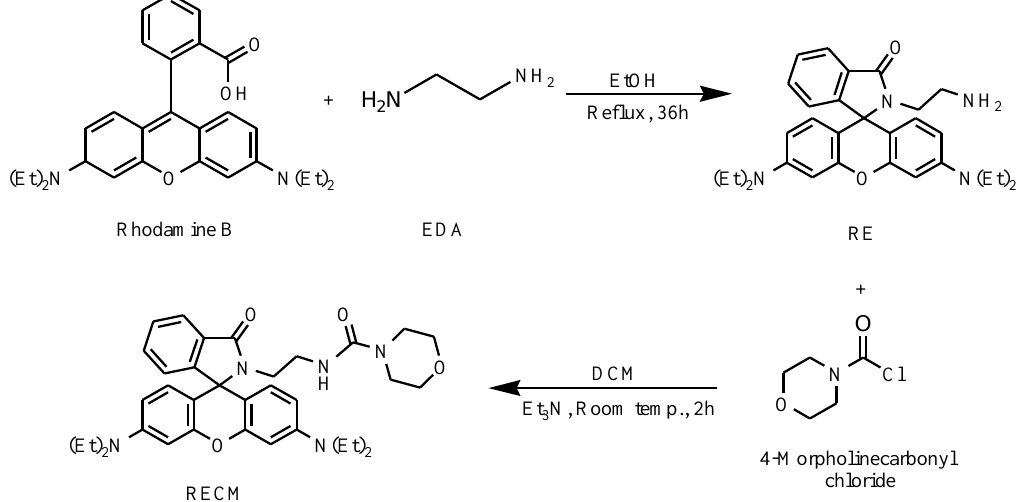
Figure 1. Synthesis route of compounds: rhodamine-B-lactam-ethylenediamine (RE) and RE–carbonyl morpholine (RECM).